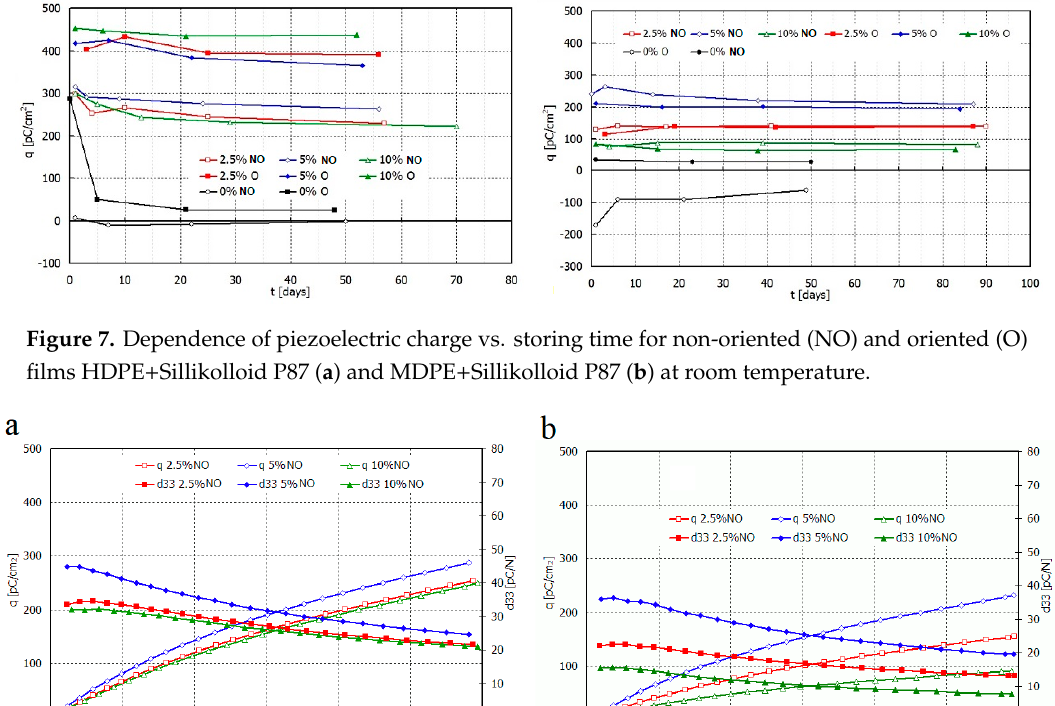
Polymers 2019 , 11 , x FOR PEER REVIEW